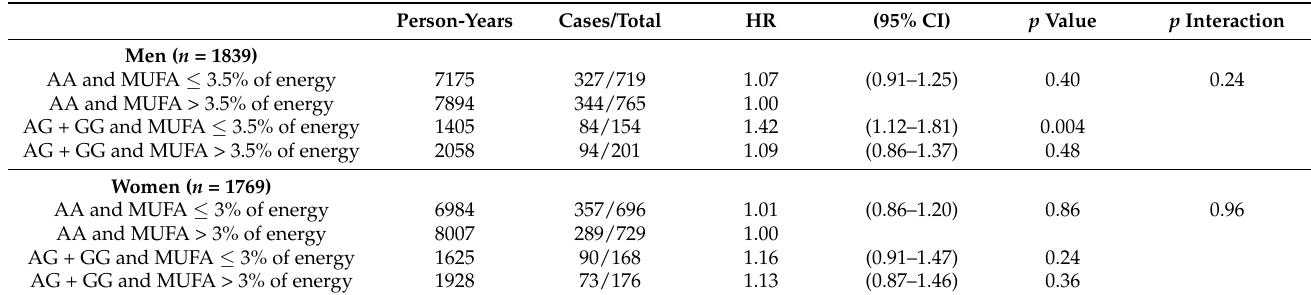
Table 5. Hazard ratios (HR) 1 for metabolic syndrome depending on the CLOCK rs1801260 genotype and dietary monoun- saturated fatty acid (MUFA)